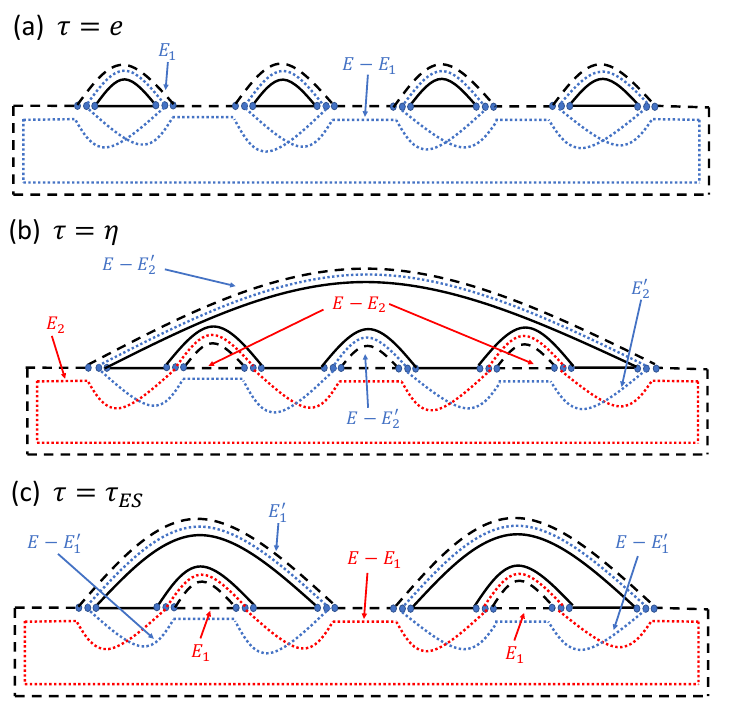
Figure 27 . Diagrams for different possible dominant contributions to Z (PT) n in the microcanonical ensemble with B at infinite temperature. Recall that dashed, dotted and solid lines respectively represent A , A , B . E are energies in A for s = 1 , 2 , and each of these energies is indepen- 0 1 2 s , E s s dently summed over in the expression for Z (PT) ( τ ) n